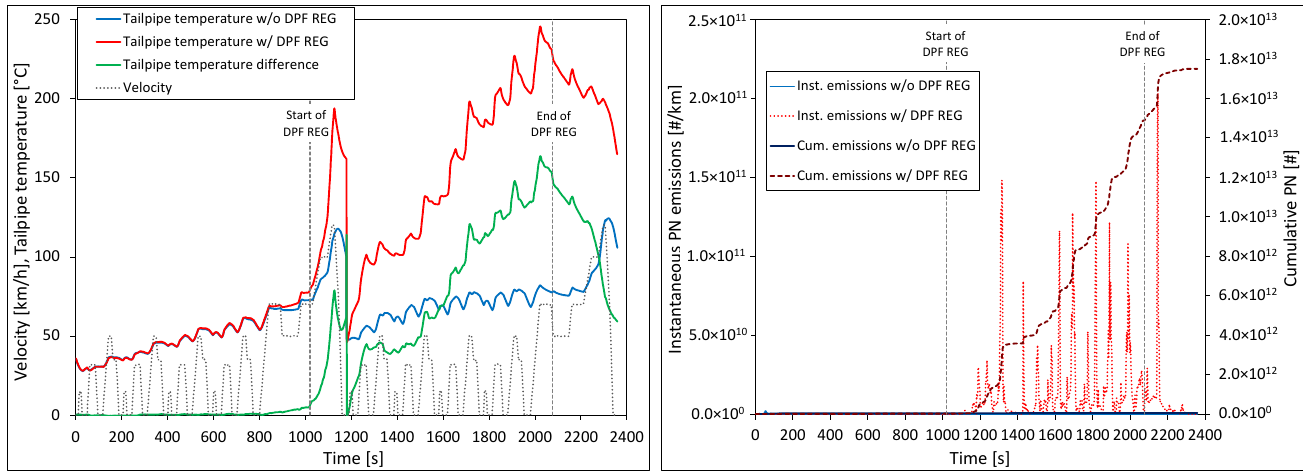
Figure 5. Indicative example of incomplete (partial) DPF regeneration in NEDC testing. ( Left ): Tailpipe temperature. ( Right ): PN emissions (the case without DPF REG is hardly visible due to the very low PN levels).